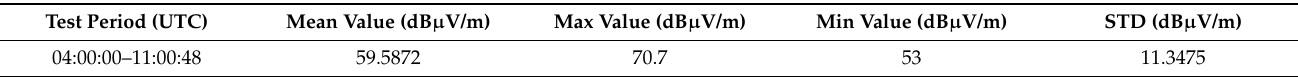
Table 3. Statistical value of the low-frequency time-code signal field strength on 21 June 2020 (the day of the annular eclipse). Test Period